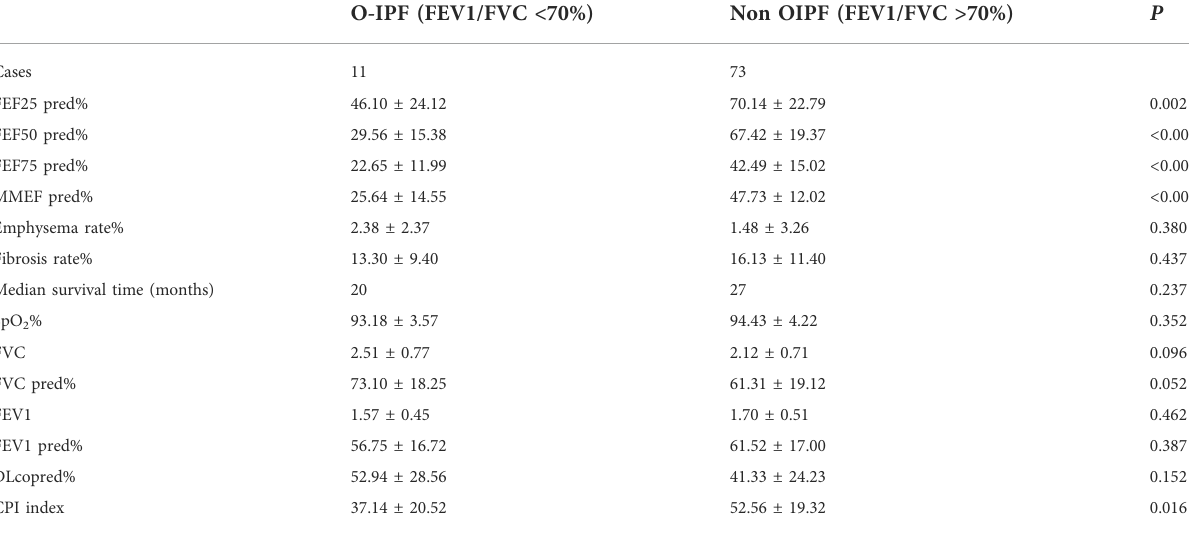
TABLE 2 Comparison between with and without obstructive ventilatory dysfunction in patients with IPF combined small airway